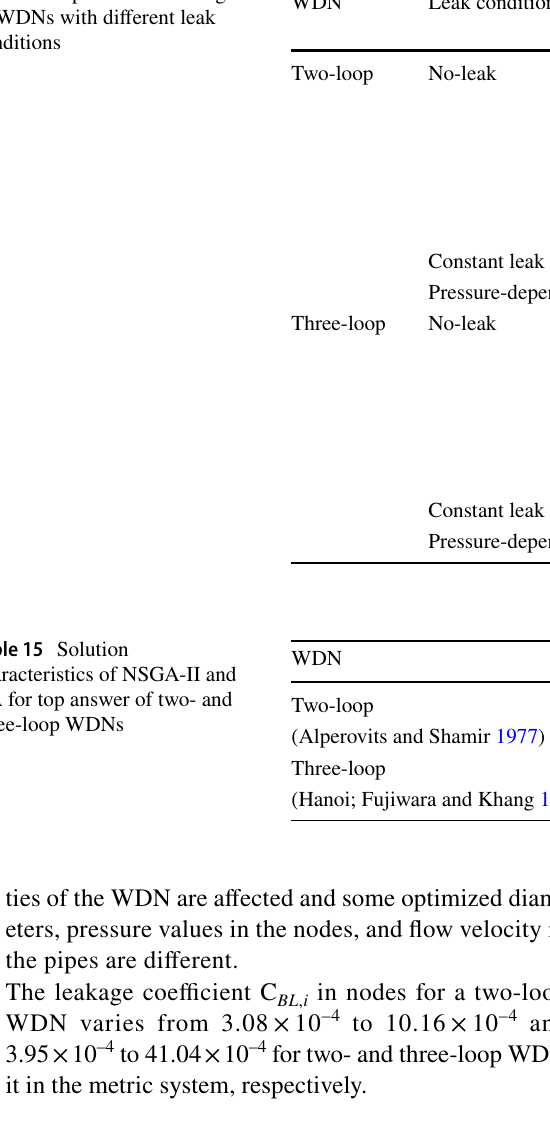
Table 14 Optimal Cost changes of WDNs with different leak conditions